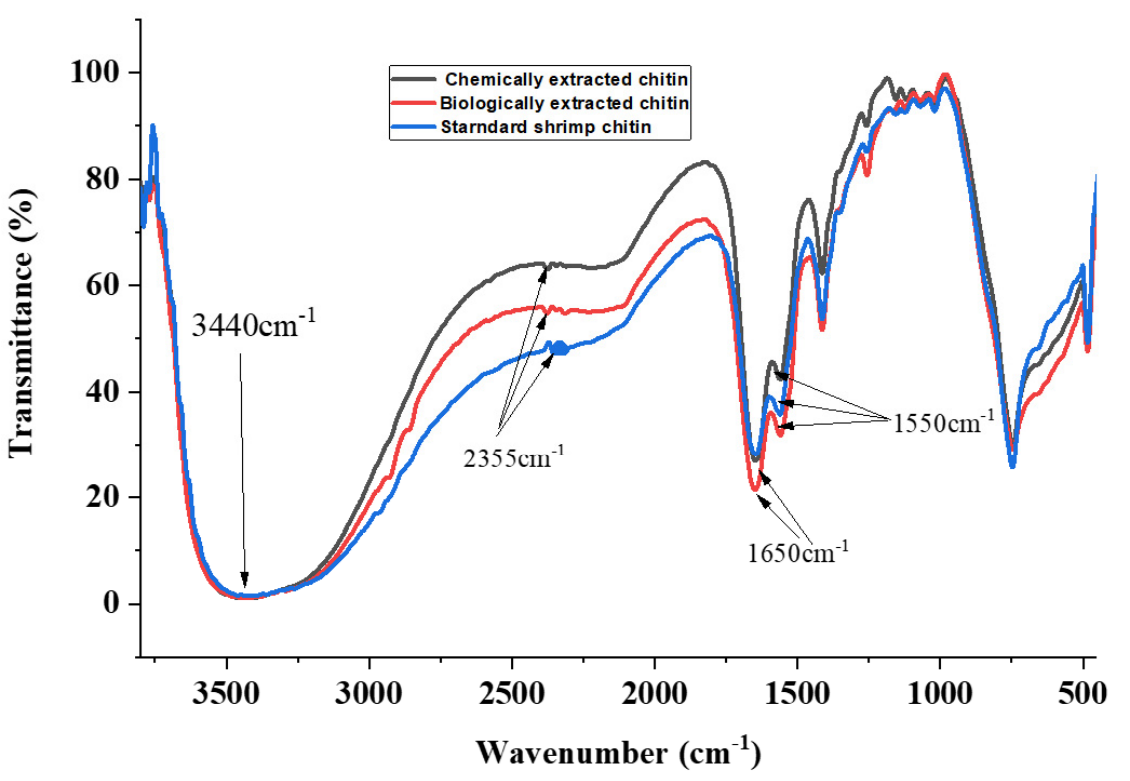
Figure 1. FTIR spectra of chitin extracted from BSF pupae shells via biological and chemical means, compared to commercial standard shrimp chitin (Sigma Aldrich, St. Louis, MI,